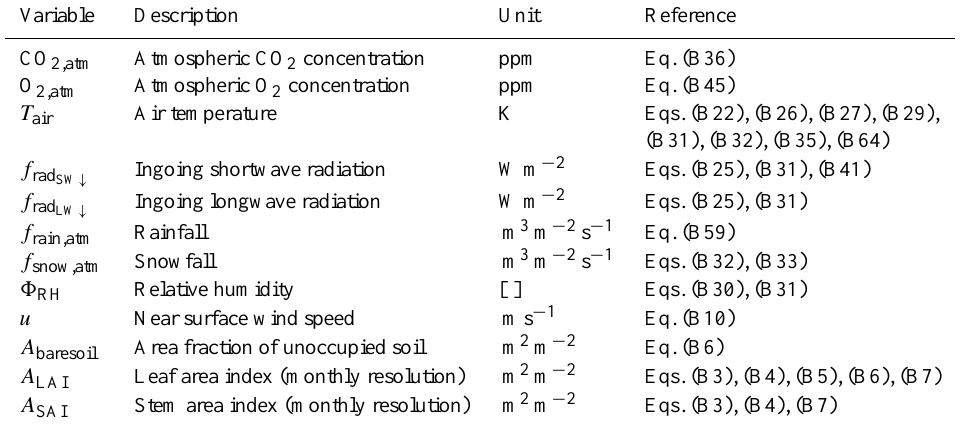
Table B12. Boundary conditions for the model.